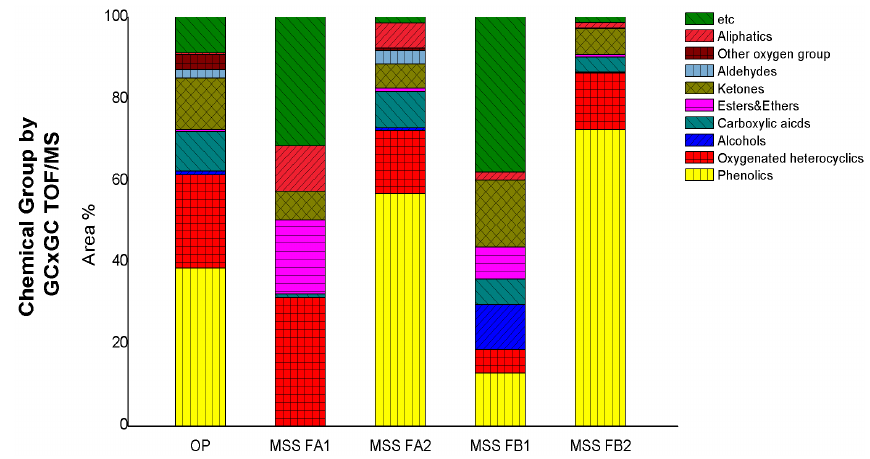
Figure 6. Chemical group compositions of OP and multi-step separation fractions.